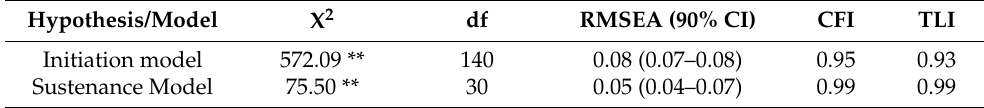
Table 2. Values of selected fit statistics for the hypothesized measurement and full structural models.